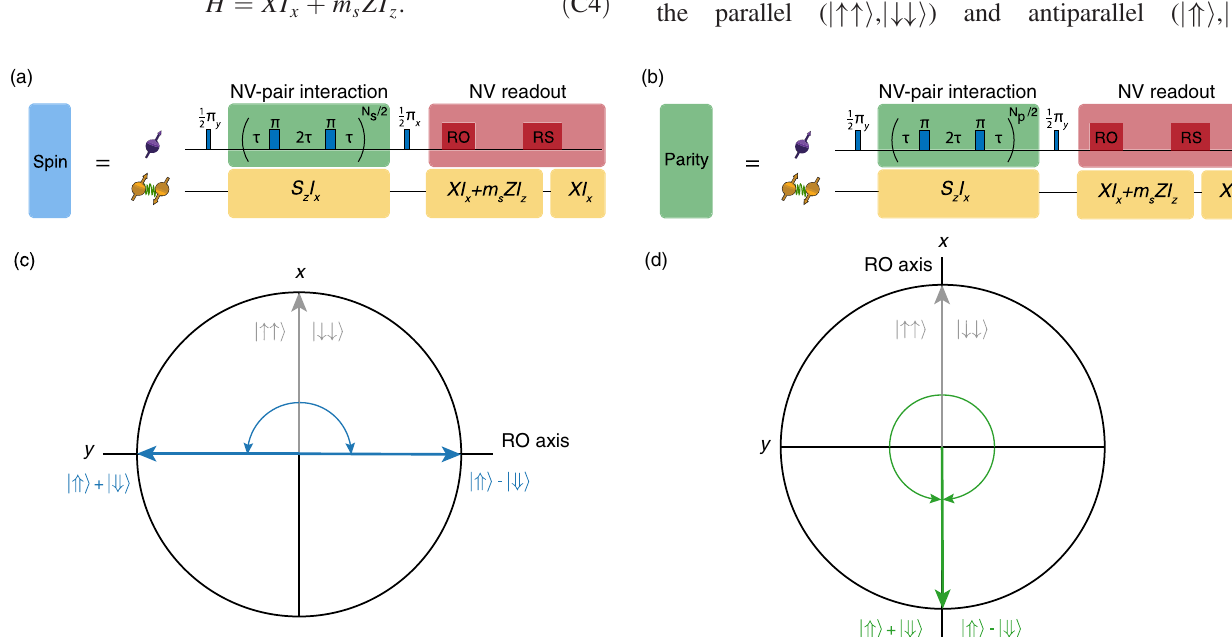
FIG. 6. Projective spin and parity measurements for pair C . (a) Sequence to measure the spin state of pair C . The NV starts in m s ¼ 0 . ˆ S ˆ I Because Z ≫ X , the effective interaction between the NV spin and pseudospin is z x . During the NV readout (RO) and reset (RS), the NV can spend an unknown time in m s ¼ − 1 which causes dephasing of the pair spin. Additionally, pair C undergoes a deterministic z rotation for any known time spent in m s ¼ − 1 . To minimize these effects, we use a fast readout and reset. N s ¼ 8 . (b) Sequence to measure the parity of the two spins that make up pair C . Note that in this case the timing of the sequence is unimportant, as evolution in m − 1 or m 0 does not change the parity. N 14 . (c) XY plane of the NV Bloch sphere during the NV-pair interaction in (a). The s ¼ s ¼ p ¼ NV picks up a positive or negative phase depending on the x projection of the pair pseudospin and no phase when the pair is in the parallel subspace. (d) XY plane of the NV Bloch sphere during the NV-pair interaction in